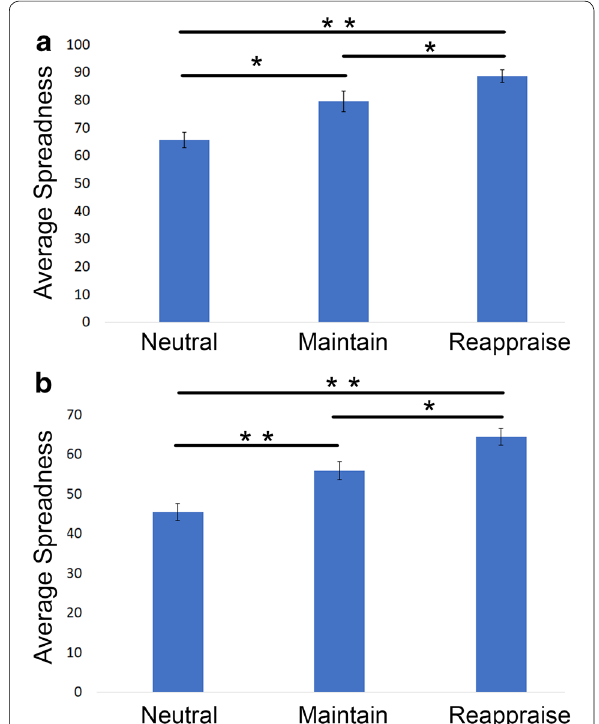
Fig. 7 Spreadness of each condition in 2-D isomap spaces, both k-nearest neighbor approach ( a ) and the epsilon-based approach ( b ). In k-isomap, the spreadness in Neutral : 65.61 ± 2.74 , Maintain : 79.51 ± 3.64 , Reappraise : 88.67 ± 2.27 ; in ε -isomap, the spreadness in Fig. 8 Average trajectory length of Neutral , Maintain and Reappraise across a range of k values in the k-nearest neighbor step ( a ) and the Neutral : 45.43 ± 2.09 , Maintain : 55.78 ± 2.27 , Reappraise : 64.30 ± 2.09 . number of connected connectomes with a range of ε values ( b Both suggest the Thought Chart is more scattered as the task condition becomes more complex. Significant findings in group t test 0.01 0.05 are indicated with ** p < and * p <